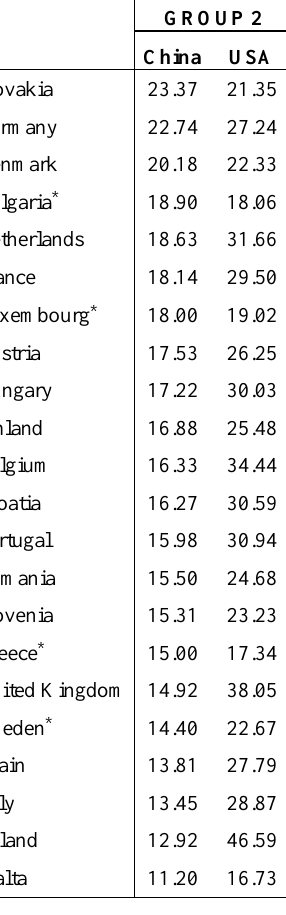
Table 3: Distribution of Countries by Importance of Trade Destination in 2014 (% of Total Value-Added Exports) GROUP 1 GROUP 2